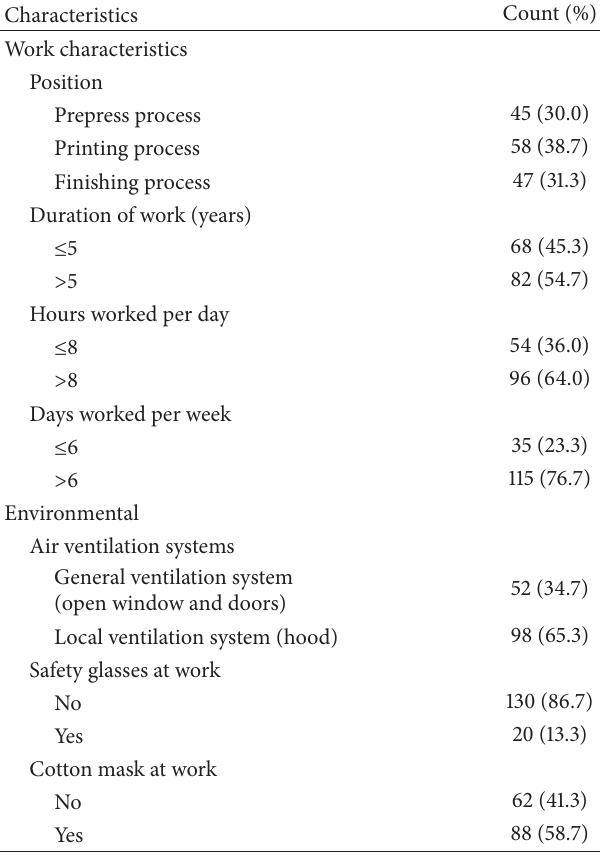
Table 4: Prevalence of eye irritation in the preceding 6